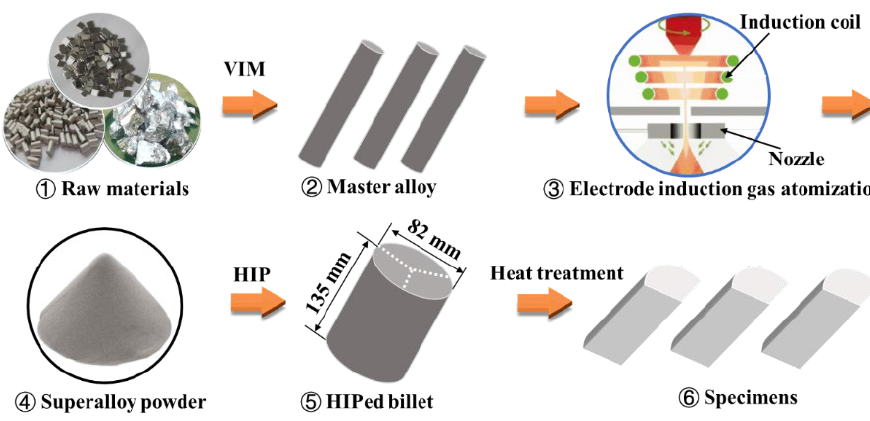
Figure 1. Schematic diagram of material preparation. Table 1. The composition of the P/M superalloy FGH4107 in wt.%.